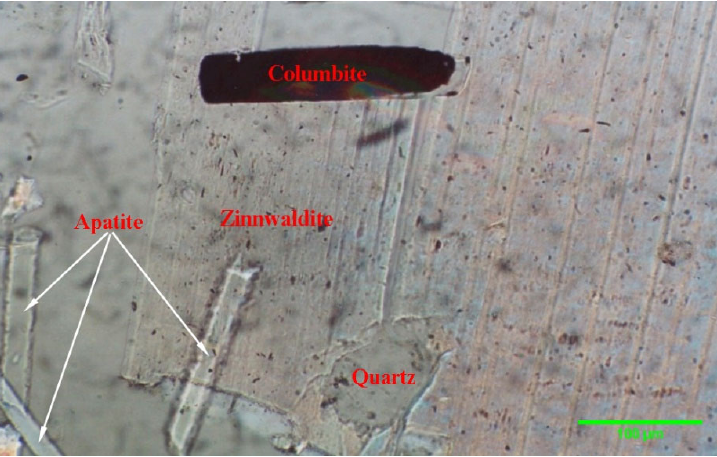
Figure 7. Columnar columbite trapped in zinnwaldite.